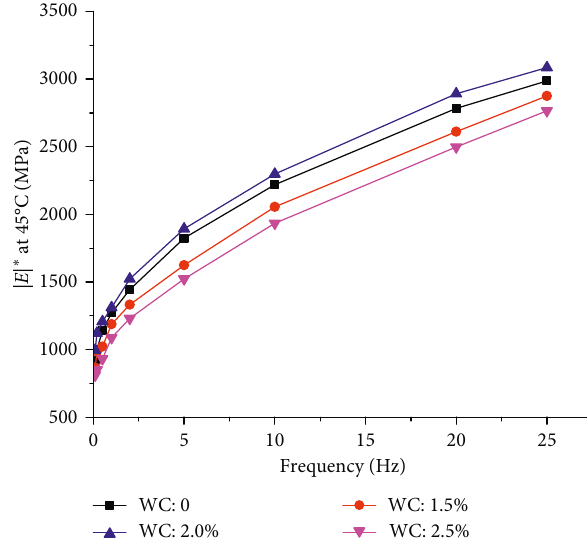
Figure 13: 70#AC-20-type high-temperature dynamic modulus.